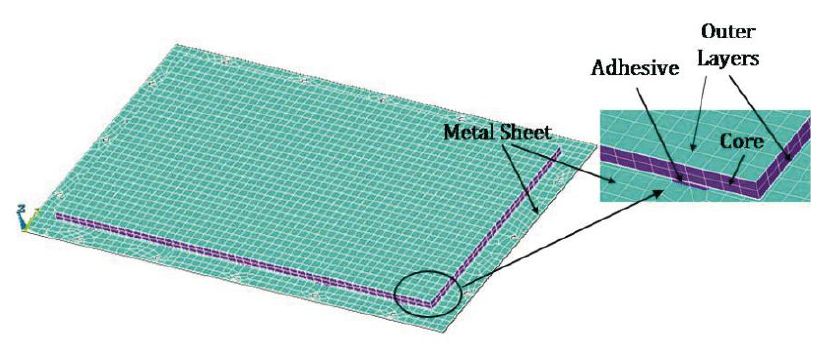
Figure 3. Metal Sheet and Multilayer Composite: 3D FEM.